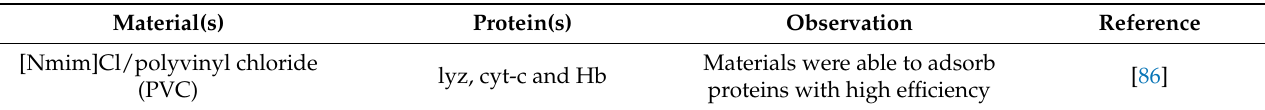
Table 2. Summary of the reported studies showing the potential of SILs to separate/recover